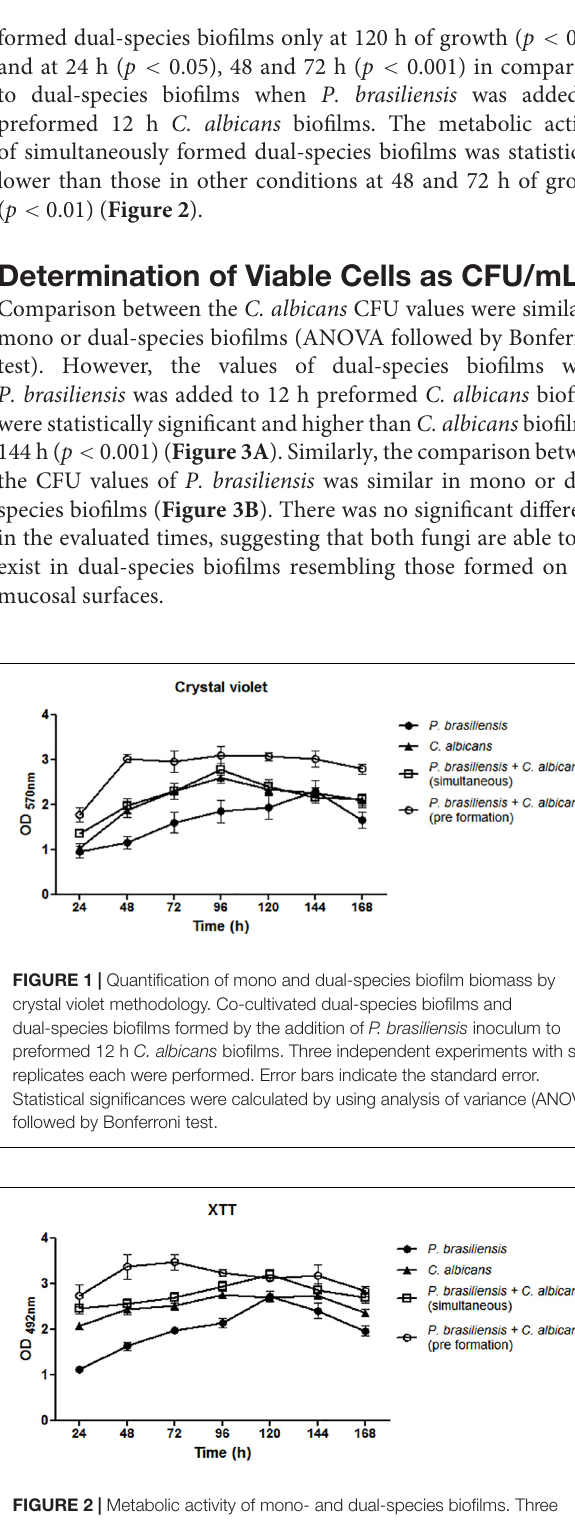
Frontiers in Microbiology |